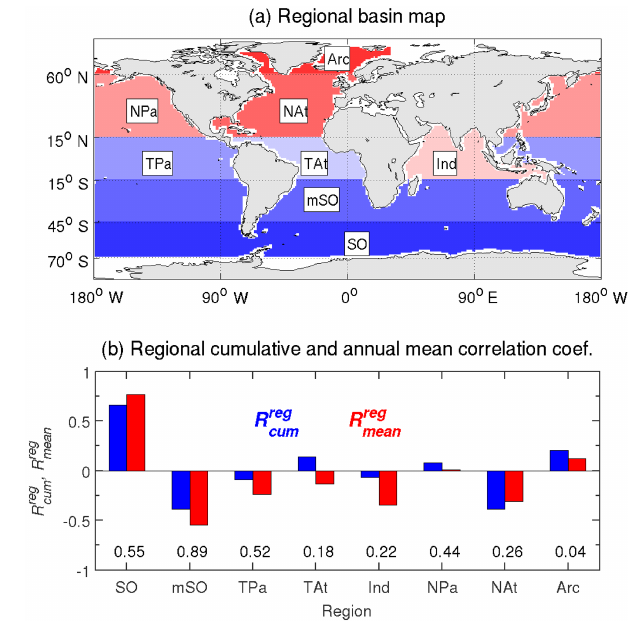
Figure 3. Panel (a) : the eight regional ocean basins adopted in this study, defined according to different ocean basins and latitudinal lines of 70, 45, 15 ◦ S, 15, and 60 ◦ N, and (b) correlation coefficient between regional contemporary CO 2 uptake rate with (red bars) future uptake rate in the 2090s and (blue bars) cumulative carbon uptake in the 21st century. The numbers over the x axis on panel (b) represent the area of each region (in 10 8 km 2